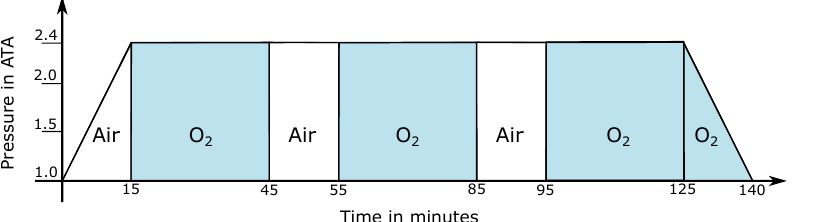
Figure 1. Diagram of the HBO therapy scheme TS 240-90 [3,4]. Air is defined as normal ambient air. Oxygen (O 2 ) represents the administration of pure oxygen. The ordinate shows the pressure in atmospheres absolute, the abscissa shows the treatment time in